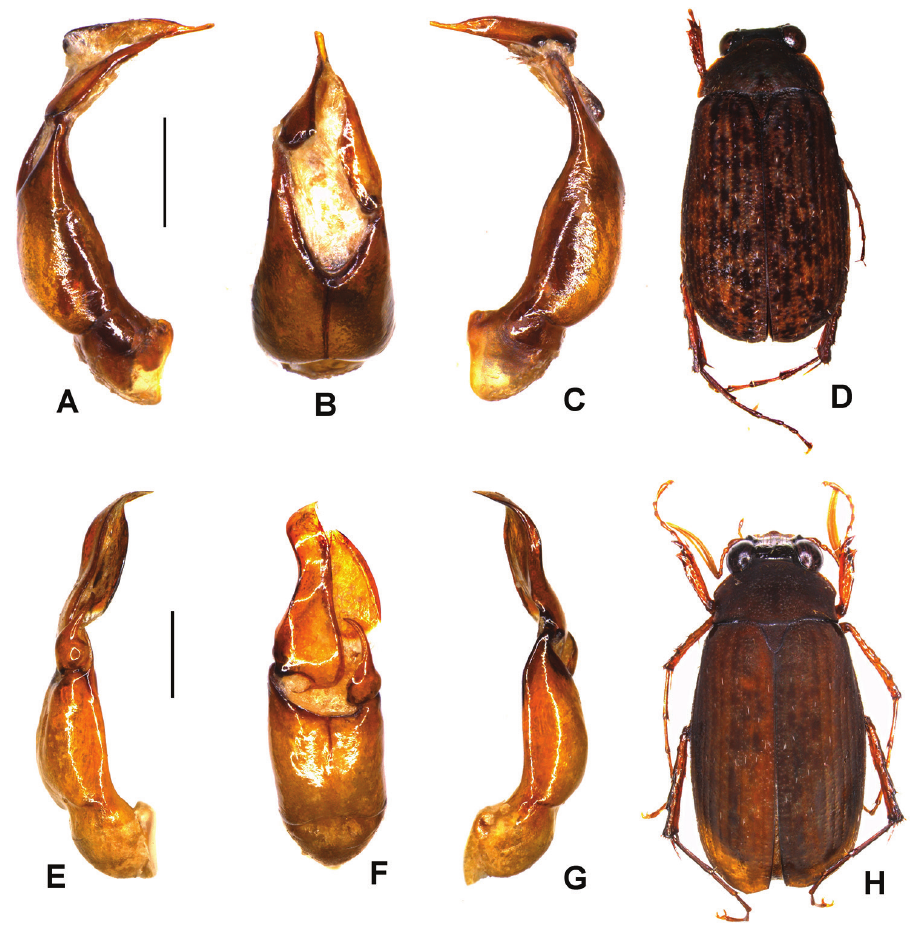
Figure 4. A–D Serica therathumensis sp. n. (holotype) E–H M. zianii sp. n. (holotype) A, E aedeagus, left side lateral view C, G aedeagus, right side lateral view B, F parameres, dorsal view D, H habitus. Scale bar: 0.5 mm. Habitus not to